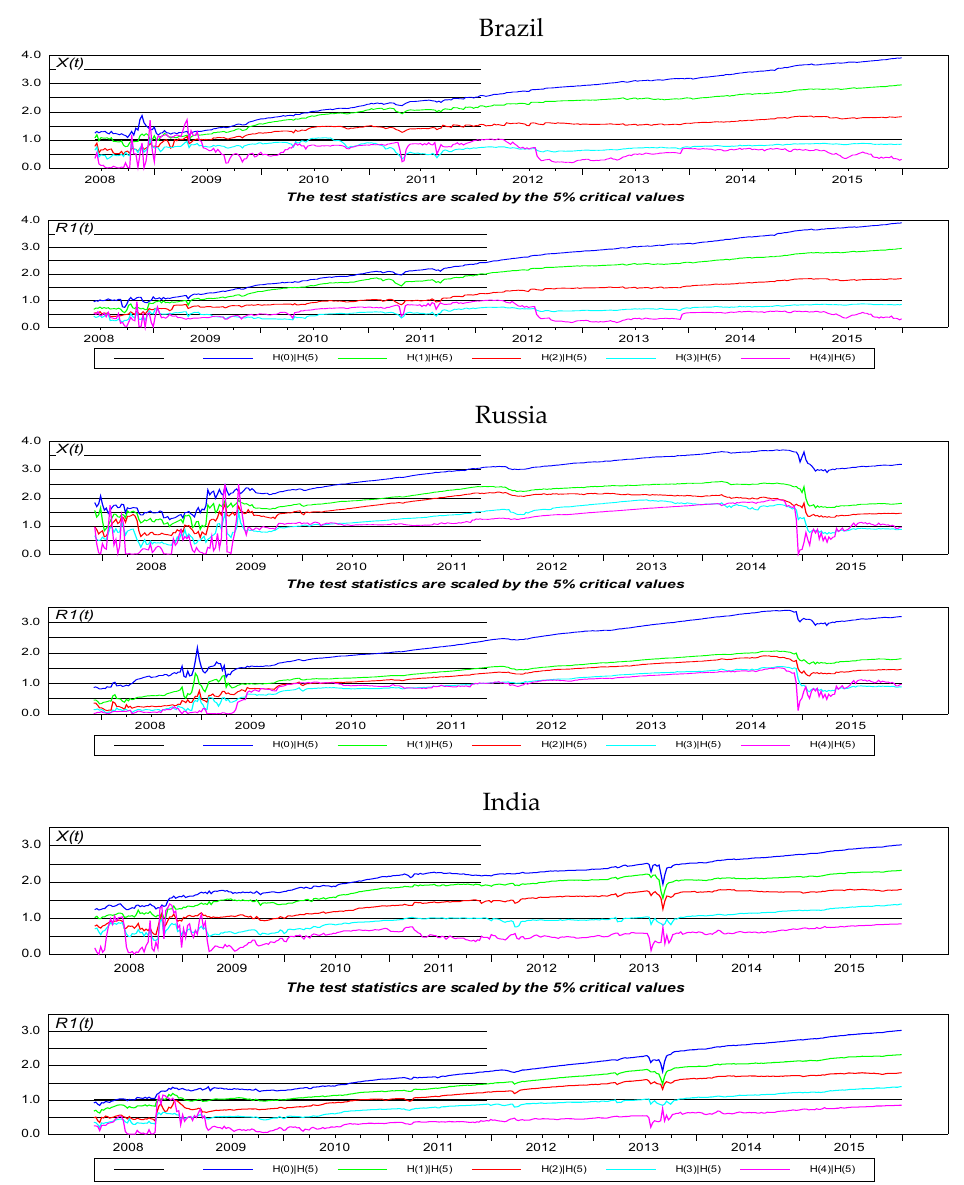
Figure A1. Trace Test Statistics. Note: “X-representation” denotes that all parameters of the cointegrated VAR system are re-estimated during the recursions, while under the “R-representation”, only the long-run parameters are re-estimated. The graphs are scaled by the 5% critical value and we accept the null hypothesis that the chosen rank is maintained if it takes values greater than one, regardless of the sub-period it has been estimated